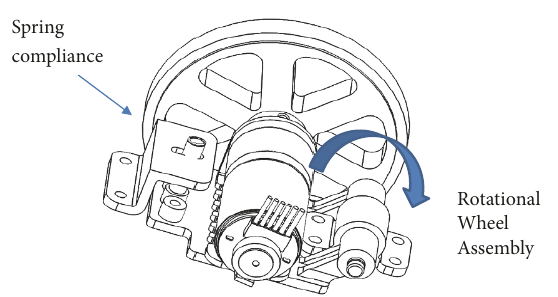
Figure 3: Compliant wheel mechanism for various surface condi- tions.